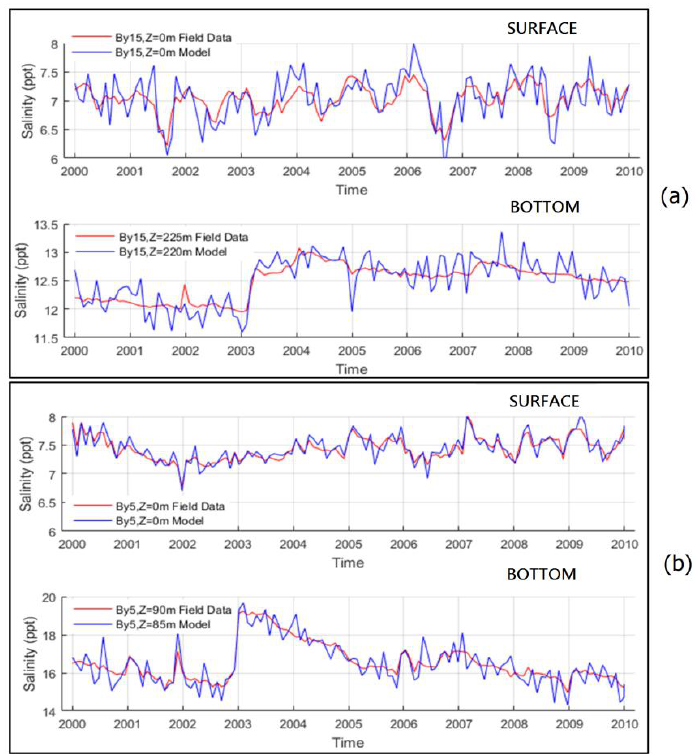
Figure 9. ( a ) Comparison of model predicted and measurements of salinity in the Baltic Sea at the Station BY15 surface and bottom for the time period 2000–2009; ( b ) Comparison of model predicted and measurements of salinity in the Baltic Sea at the Station BY5 surface and bottom for the time period